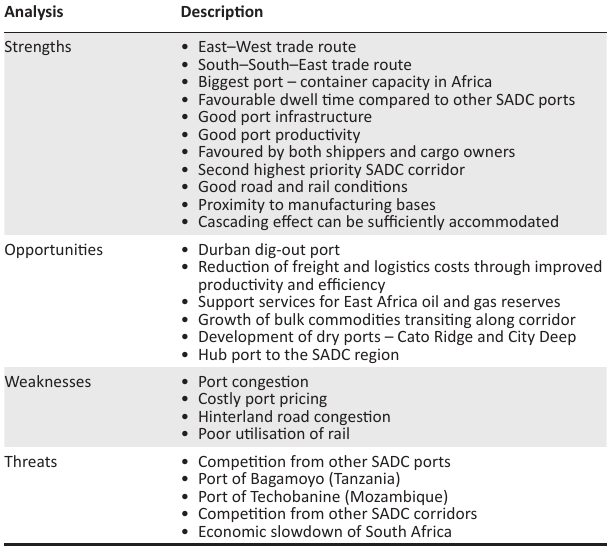
TABLE 6: Strengths, weaknesses, opportunities and threats analysis of Durban port. Analysis Description